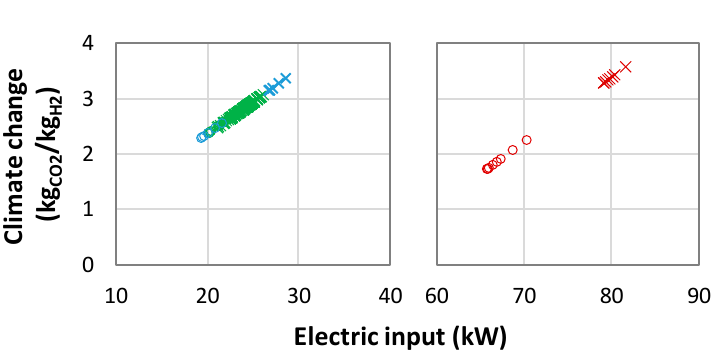
Figure 8. Scenario 2 results: climate change impact as a function of the auxiliary electric consumptions for the three investigated systems.